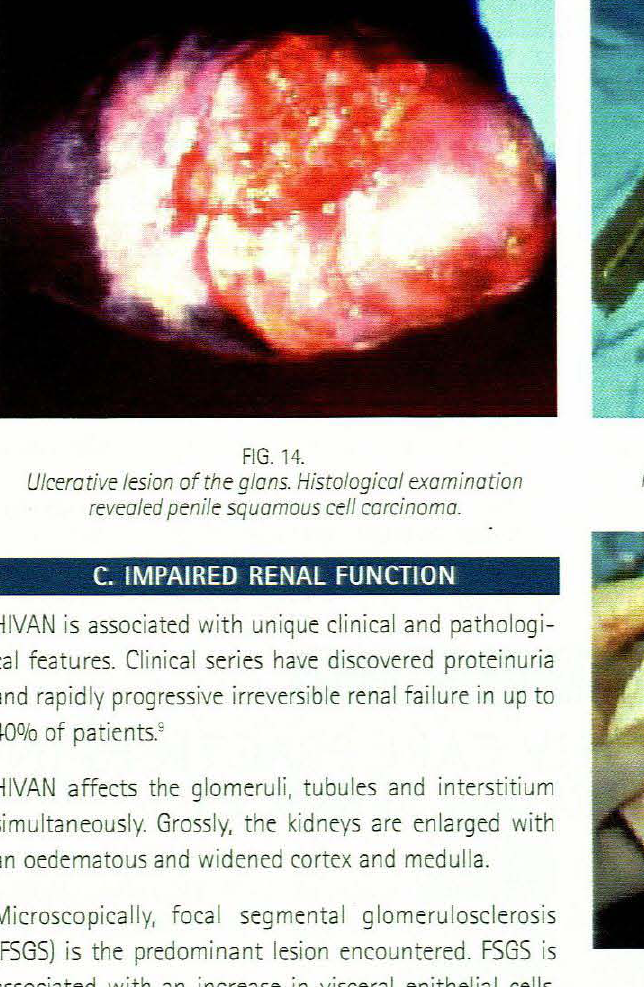
FIG. 15. Huge ulcerating moss of the prEcuce - penile cancer.